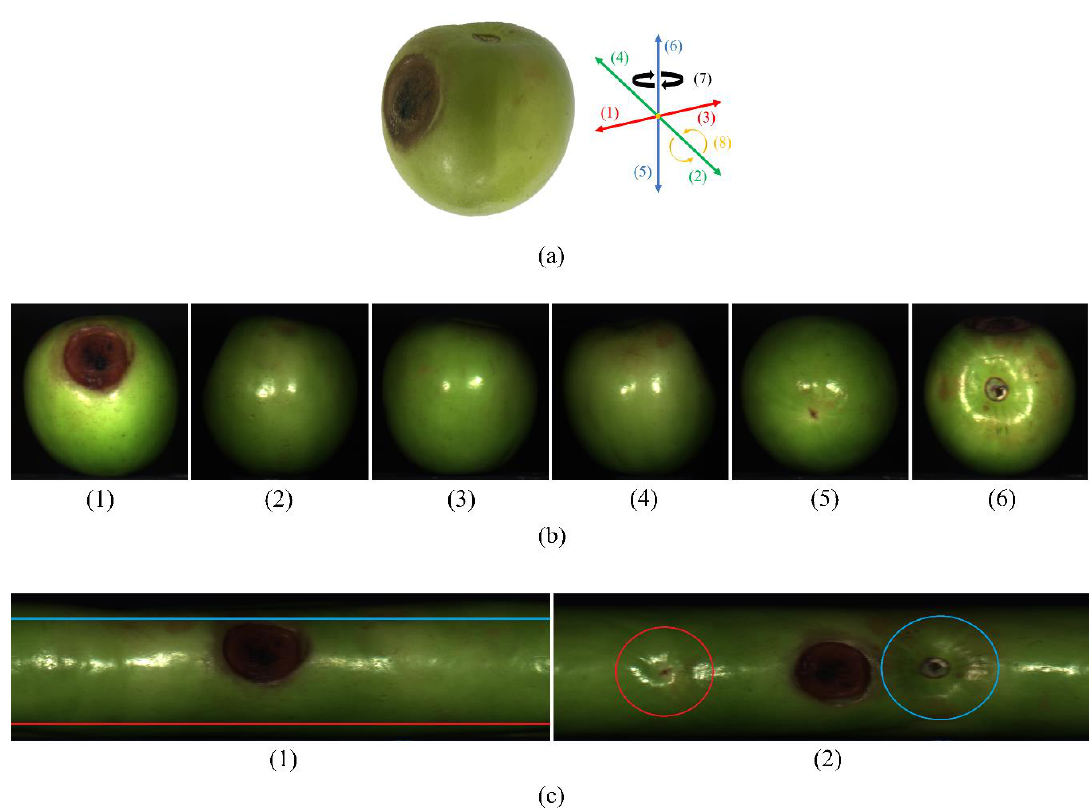
Figure 4. ( a ) Left: The photo of a typical jujube specimen. Right: The directions of faces for linear scan and the axes of rotation for rotation scan. ( b ) The pseudo color images of typical jujube specimen obtained by linear scan. From left to right: front, right, back, left, bottom and top views. ( c ) The pseudo color images of typical jujube specimen obtained by rotation scan. Left and right: rotation about axis 6 and axis 2.